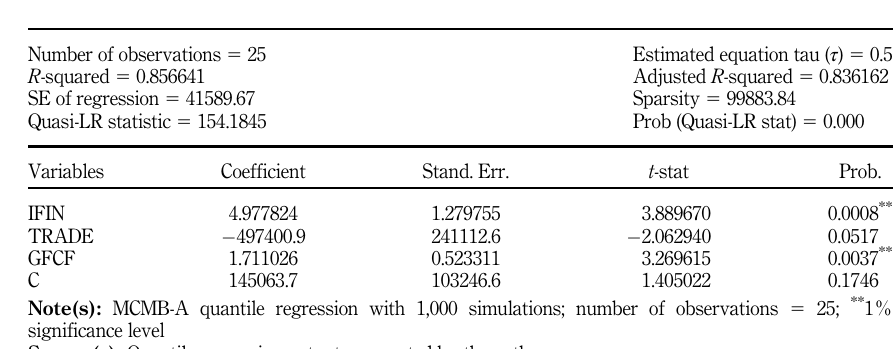
Table 3. Stationarity tests using the ADF test